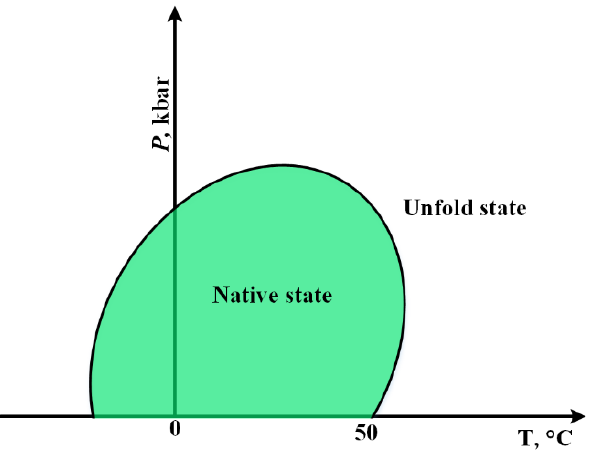
Figure 3. The relationship between pressure and temperature during the folding and unfolding of proteins ([54]).